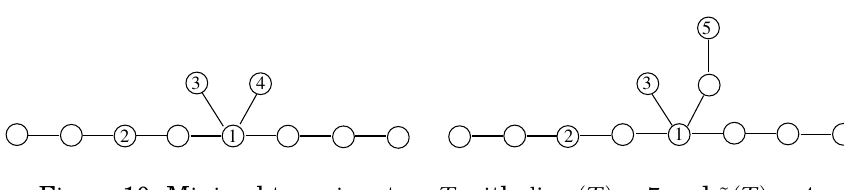
Figure 10: Minimal trees in a tree T with diam( T ) = 7 and ˜ γ ( T ) = 4